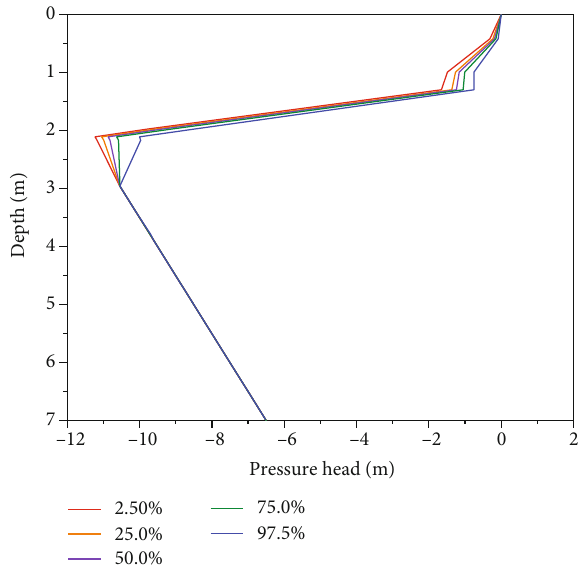
Figure 8: Pressure head at the observation pro fi le with di ff erent percentiles of the SWRC ( t = 96 h ).